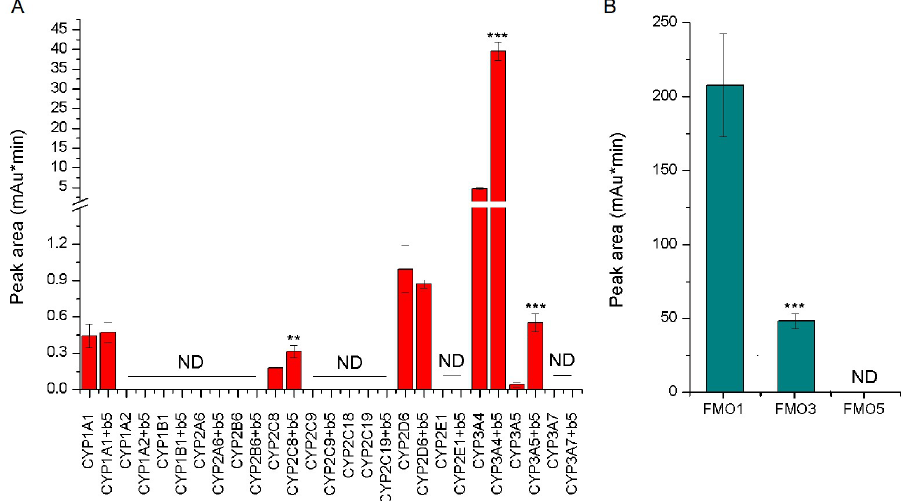
Figure 5. Oxidation of vandetanib to N -desmethylvandetanib by human recombinant CYPs ( A ) and FMOs ( B ). Values represent mean ± SD of three independent in vitro incubations ( n = 3). *** p < 0.001, ** p < 0.01 significant di ff erences between formation of N -desmethylvandetanib by CYP enzymes with and without cytochrome b 5 (b5) in Panel ( A ) and *** p < 0.001 significant di ff erences between formation of vandetanib- N -oxide in Panel ( B ). (ANOVA with post-hoc Tukey HSD Test). ND—not